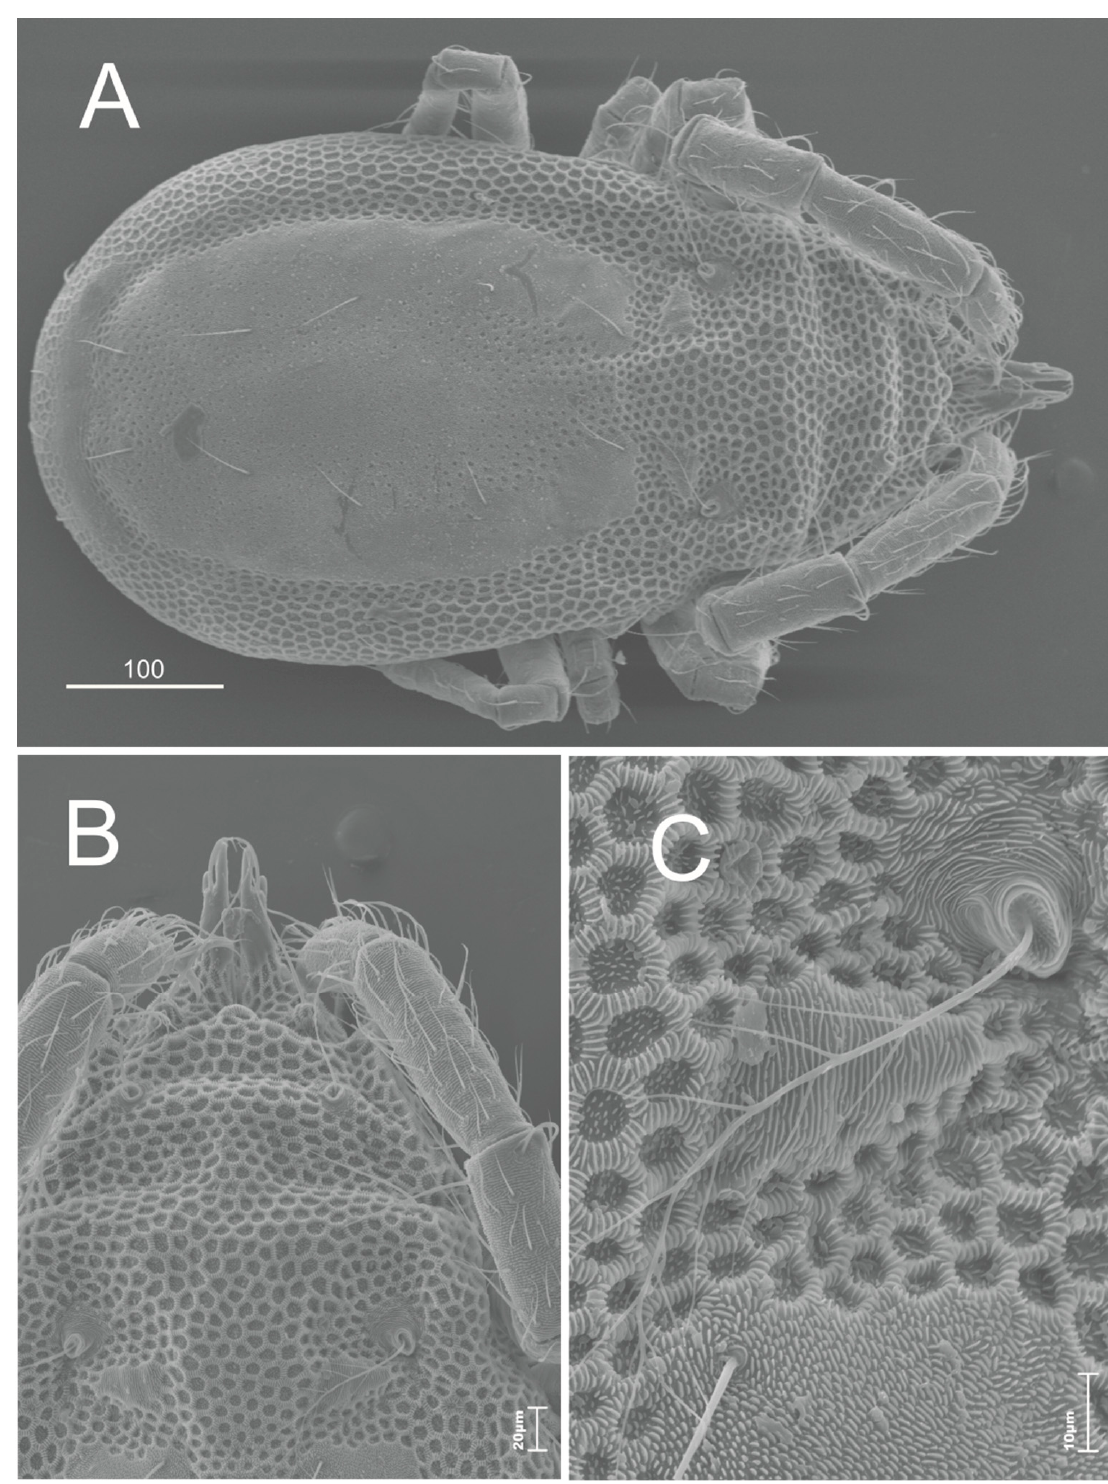
Figure 1. Male of L. luteum —dorsal side: ( A )—overall view; ( B )—anterior part of dorsal idiosoma with central eye and bothridia; ( C )—body surface sculpture, bothridium and plumose sensory seta (ultra-high resolution). SEM observations.